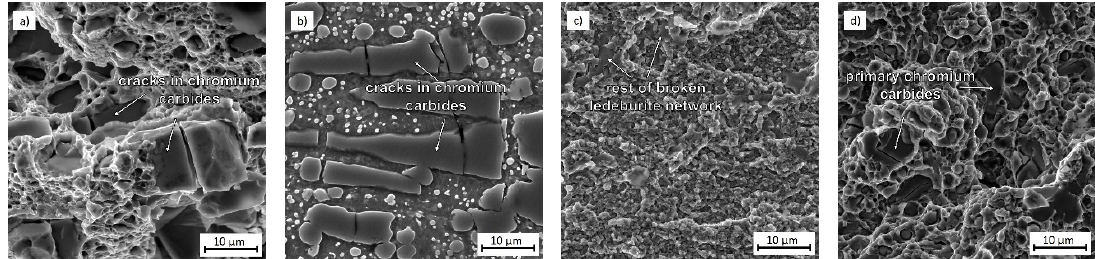
Figure 15. ( a ) As-received condition—fracture surface in a tensile test specimen, mixed fracture mode, ( b ) As-received condition—cracks in chromium carbides near the fracture location, metallographic cross section ( c ) Regime 5—1240 °C/oil: tensile fracture surface, brittle fracture, ( d ) Regime 7—960 °C/oil–250 °C/60 min: tensile fracture surface: brittle fracture.